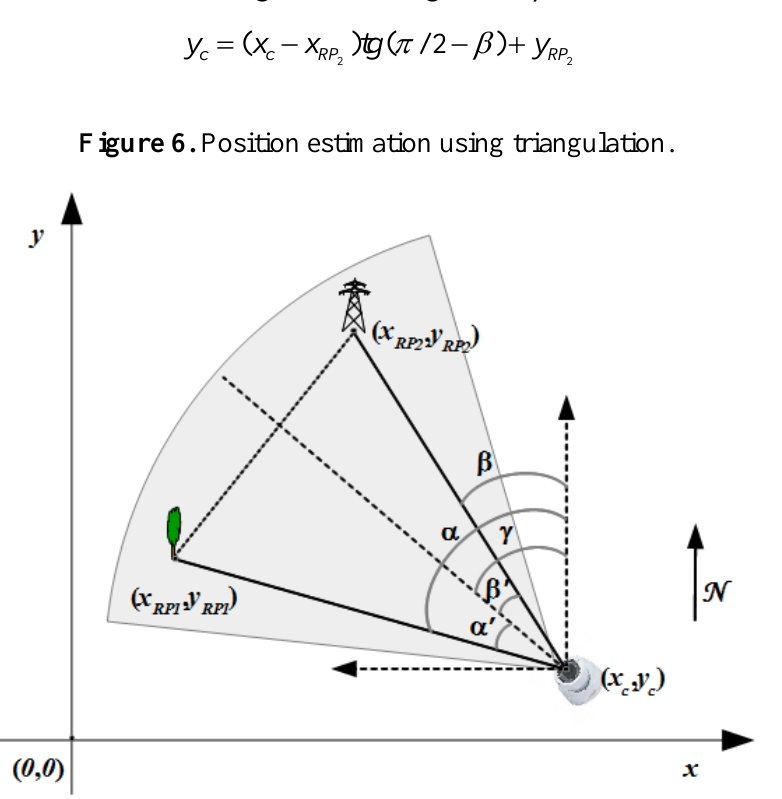
Figure 6. Position estimation using